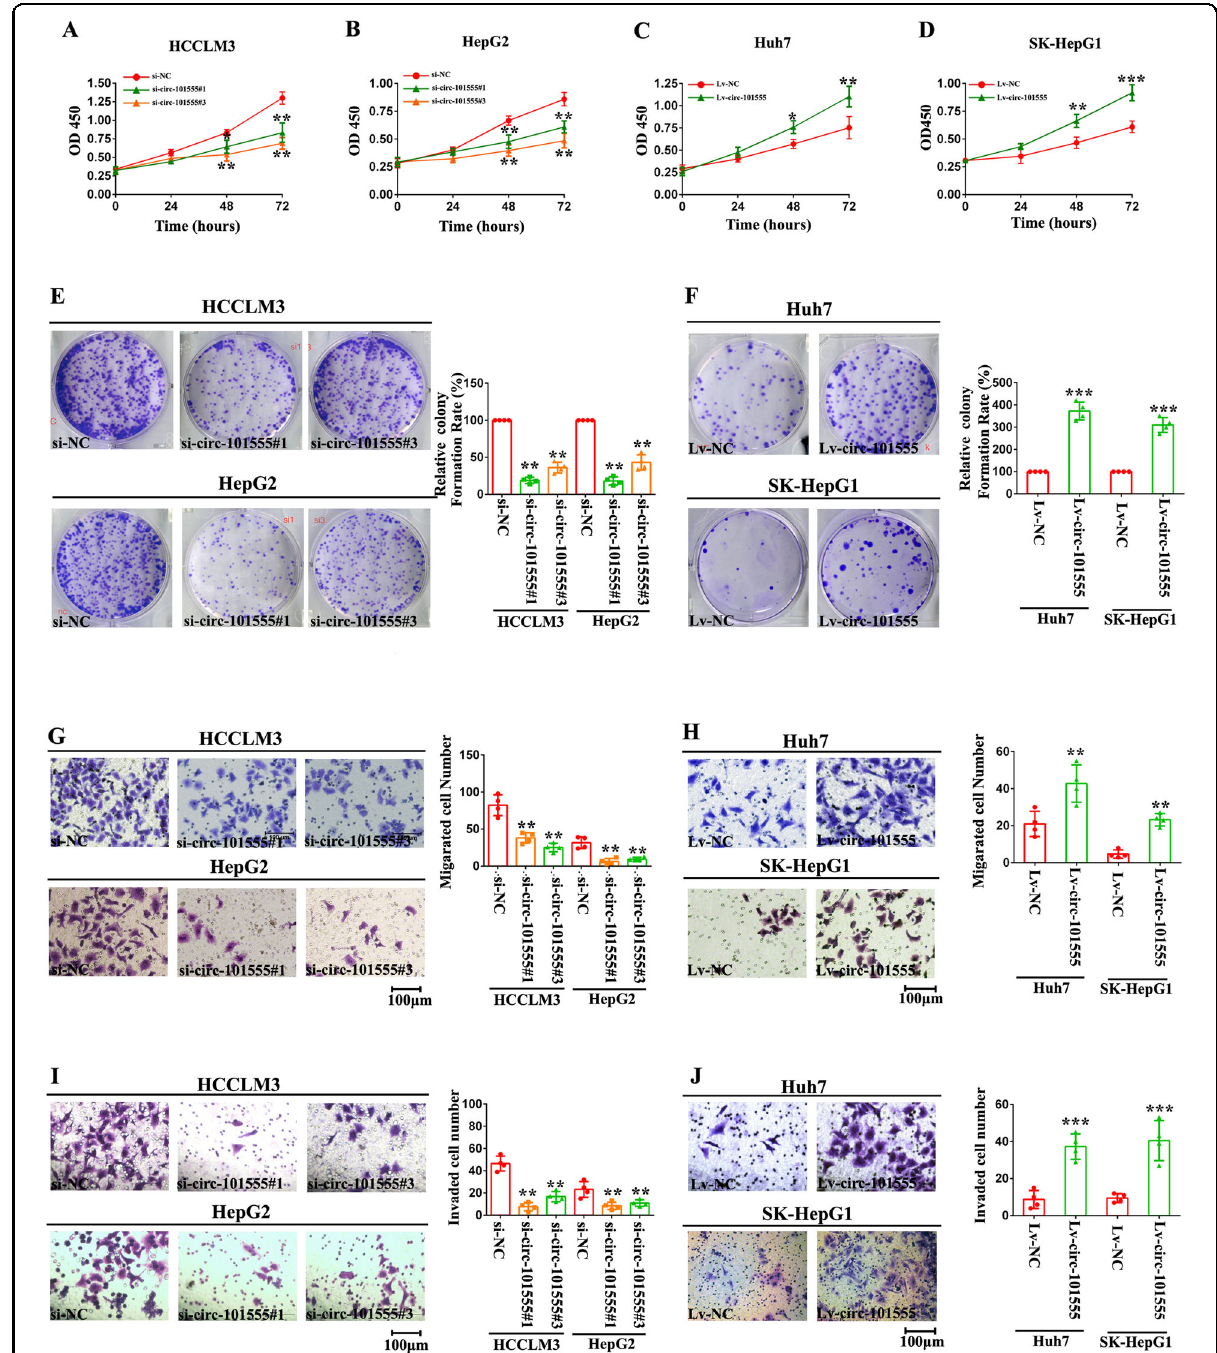
Fig. 3 hsa_circ_101555 acts as an oncogene in HCC. A , B Proliferative capacity of HCCLM3 and HepG2 cells transfected with siRNA- hsa_circ_101555, or siRNA-NC, evaluated by WST-1 assay (* P < 0.05; ** P < 0.01; n = 4). C , D WST-1 assay results in lv- hsa_circ_101555 transfected Huh- 7 and SK-Hep-1 cells (* P < 0.05; ** P < 0.01; *** P < 0.001; n = 4). E Colony formation assay evaluating the proliferative ability of HCCLM3 and HepG2 cells transfected with siRNA-hsa_circ_101555 or siRNA-NC (** P < 0.01; n = 4). F Effect of hsa_circ_101555 overexpression on Huh-7 and SK-Hep-1 cells examined by colony formation assay (*** P < 0.001; n = 4). G Cell migration capability of HCCLM3 and HepG2 cells transfected with siRNA- hsa_circ_101555 or siRNA-NC, assessed by transwell migration (** P < 0.01; n = 4). H Effect of hsa_circ_101555 overexpression on Huh-7 and SK-Hep-1 cells, examined by transwell migration (** P < 0.01; n = 4). I Cell invasion capacity of cells transfected with siRNA-hsa_circ_101555 or siRNA-NC, evaluated by Matrigel invasion assays (** P < 0.01; n = 4). J Effect of hsa_circ_101555 overexpression on Huh-7 and SK-Hep-1 cells, examined by Matrigel invasion assays (*** P < 0.001; n =